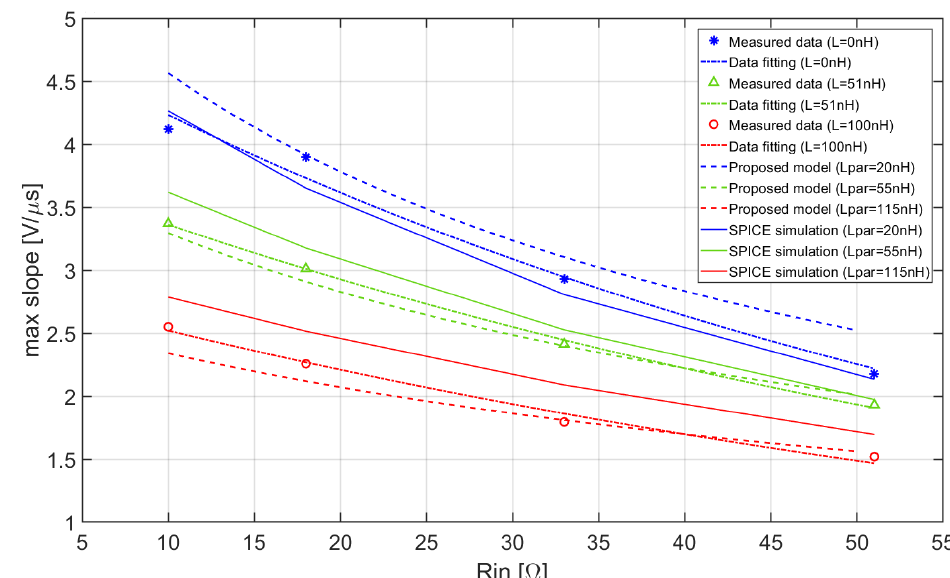
Figure 16. Maximum slopes of the output pulse of the front-end as a function of the input resistance R in for three values of parasitic inductance: comparison among measured data, proposed model predictions, and SPICE simulations.